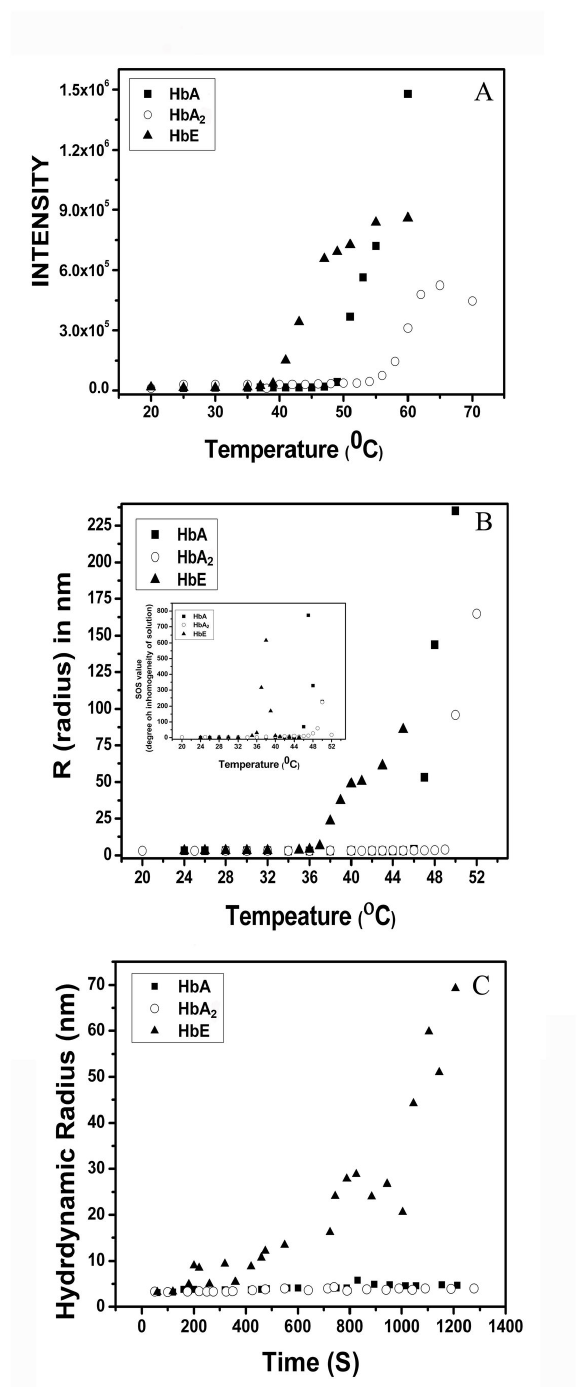
Figure 7. Thermal aggregation studies of HbA, HbA Change in the intensity of 90° light scattering at 500 nm measured in a fluorescence spectrometer at pH 7 and ( B ) the same in the hydrodynamic radius as calculated by DLS measurements. Inset of ( B ) represents the homogeneity of the species under the light scattering experimental condition in terms of SOS values. Higher value indicates more heterogeneity in the solution in terms of radii of the species present. ( C ) Oxidative instability of HbA, HbA kinetics of aggregation, obtained from the change in hydrodynamic radius of the Hb variants with time. HbE shows a marked instability compared to the rest of HbA and HbA doi: 10.1371/journal.pone.0081820.g007 PLOS ONE |